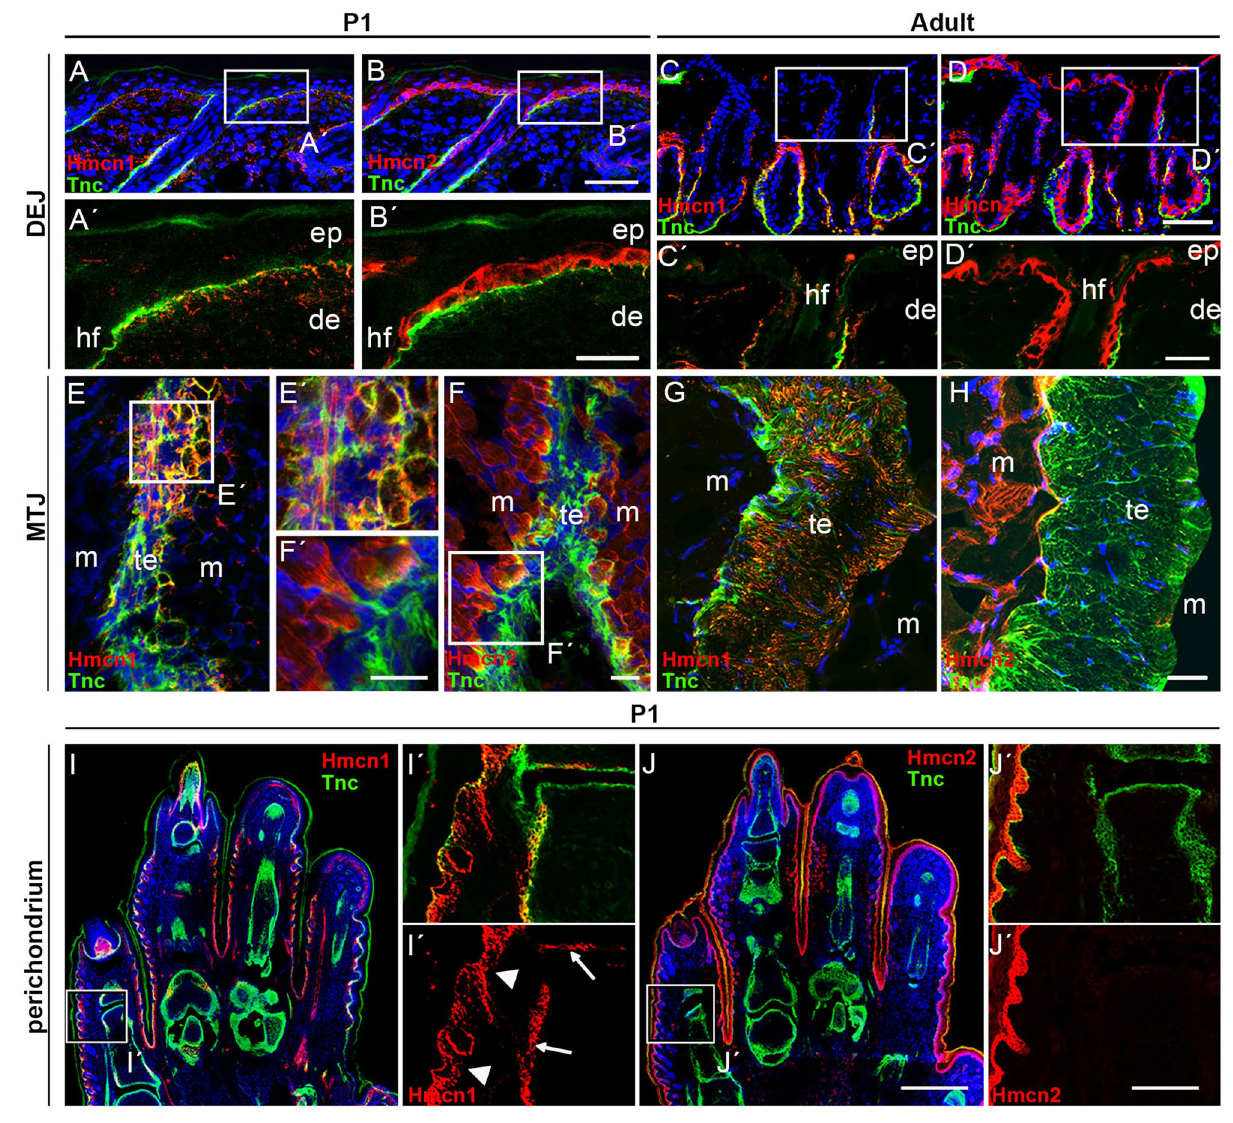
Figure 2. Complementary distribution of mouse Hmcn1 and Hmcn2 protein at the dermal–epidermal junction (DEJ), muscle–tendon junction (MTJ), and the perichondrium in neonates and adult mice. ( A – D ′ ) Immunofluorescent staining of DEJ of neonates/P1 ( A – B ′ ) and adult ( C – D ′ ) wild-type mice, counterstained for the ECM protein Tenascin C (green) and nuclear DNA (DAPI; blue). In neonates, Hmcn1 (red, A, A ′ ) is localized throughout the dermis whereas Hmcn2 (red, B, B ′ ) is distinctively localized in the pericellular space of basal keratinocytes of the epidermis. In adult, Hmcn1 is strongly concentrated on the dermal side of the basement membrane, but not detectable in the lower dermis ( C, C ′ ) and Hmcn2 is found in basal keratinocytes ( D, D ′ ). ( E–H ) Sagittal section of the calf in neonates ( E–F ′ ) and adult ( G, H ) mice, counterstained for the tendon ECM marker protein Tenascin C (green) and nuclear DNA (DAPI, blue). Hmcn1 (red, E, E ′ , G ) is found within the tendon, forming long track-like structures and Hmcn2 (red, F, F ′ , H ) in the endomysium of myofibers, with strong enrichment at the sites where myofibers are in close proximity to the tendon. ( I-J ′ ) Sagittal section of the autopod of newborn wild-type mice, counterstained with cartilage/bone ECM marker protein Tenascin C (green) and nuclear DNA (DAPI, blue). Hmcn1 (red, I, I ′ ) is present in perichondrium (white arrows) and at dermal side of BM (arrowheads) Hmcn2 (red, J, J ′ ) around basal keratinocytes of the epidermis. hf, hair follicle; ep, epidermis; de, dermis; m, muscle; te, tendon. Scale bars A – D = 50 µm; A ′ – D ′ , E – H = 25 µm; I , J = 400 µm; I ′ , J ′ = 100